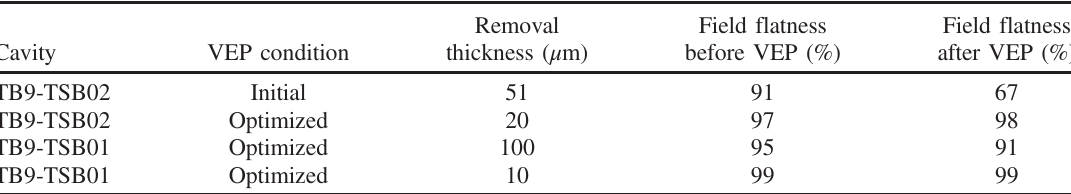
TABLE VI. Field flatness of the cavity after VEP of TB9-TSB02 and TB9-TSB01 cavities under initial and optimized VEP conditions.